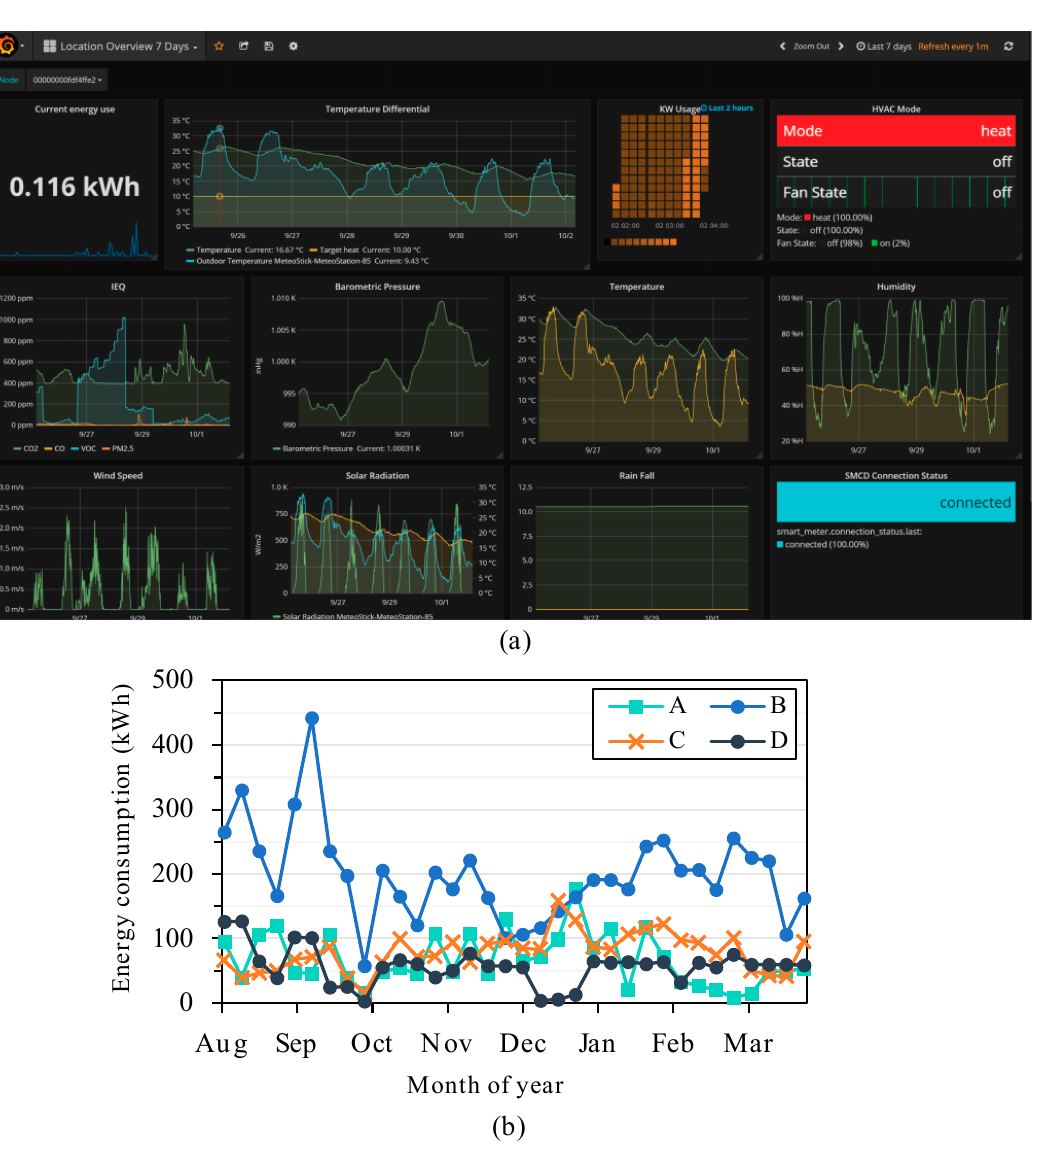
Figure 10. ( a ) Grafana—data monitoring platform in Brood used for monitoring air quality, energy and building systems in a residential setting and ( b ) 8 months of weekly energy consumption data in four apartments.